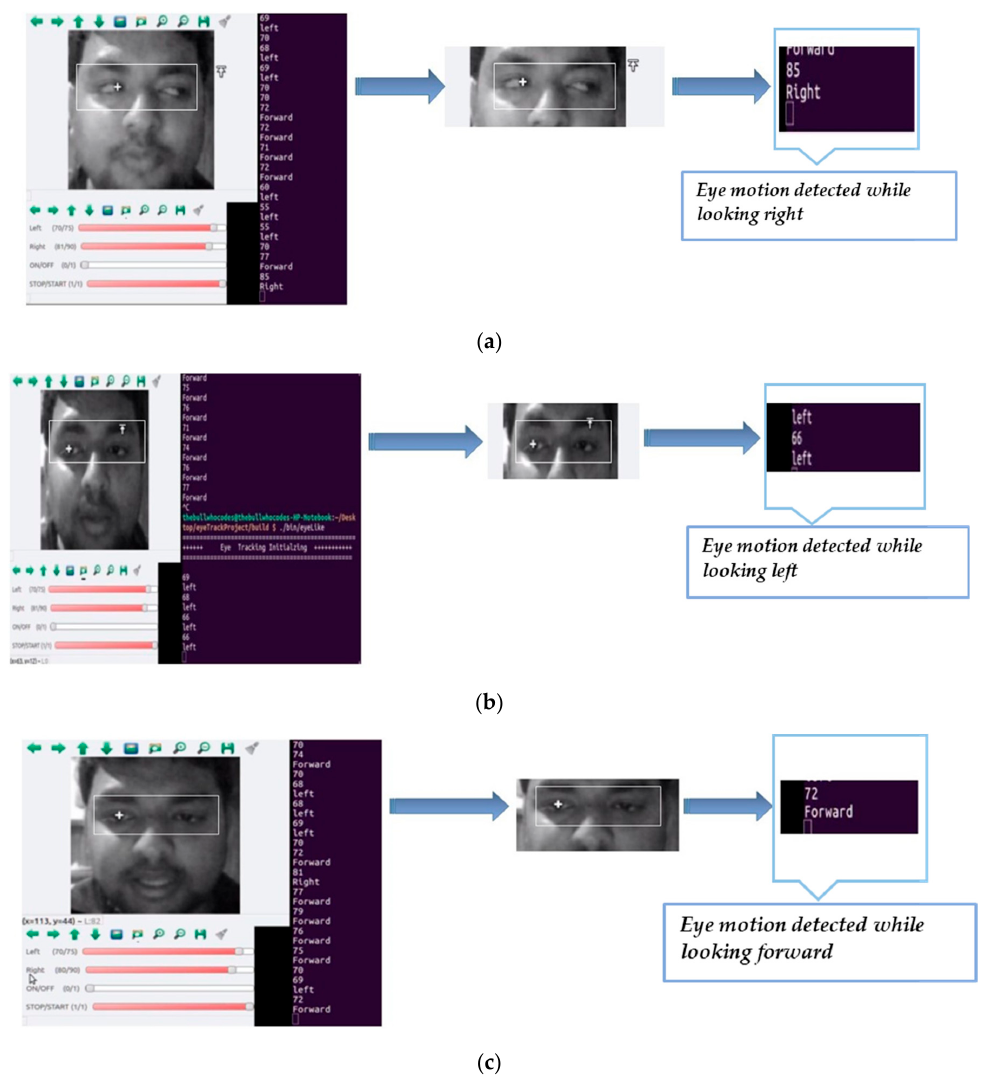
Figure 6. Designed system’s results for eye control mode ( a ) right, ( b ) left, and ( c ) forward.